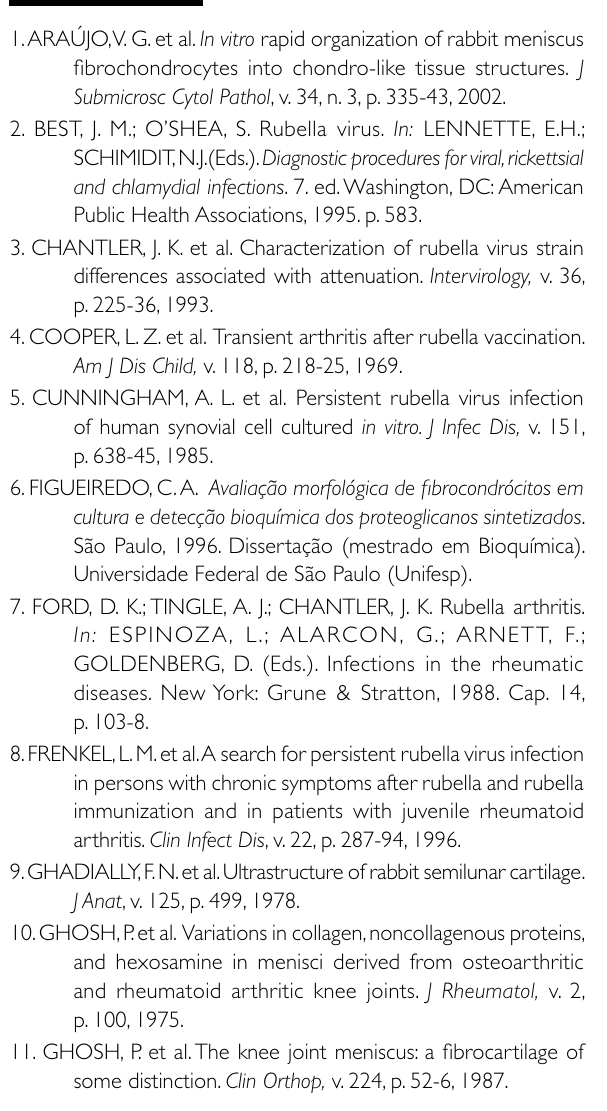
FIGUEIREDO, C. A. et al. Infectivity of wild-type rubella virus in fibrochondrocyte cells • J Bras Patol Med Lab • v. 40 • n. 1 • p. 1-5 • fevereiro